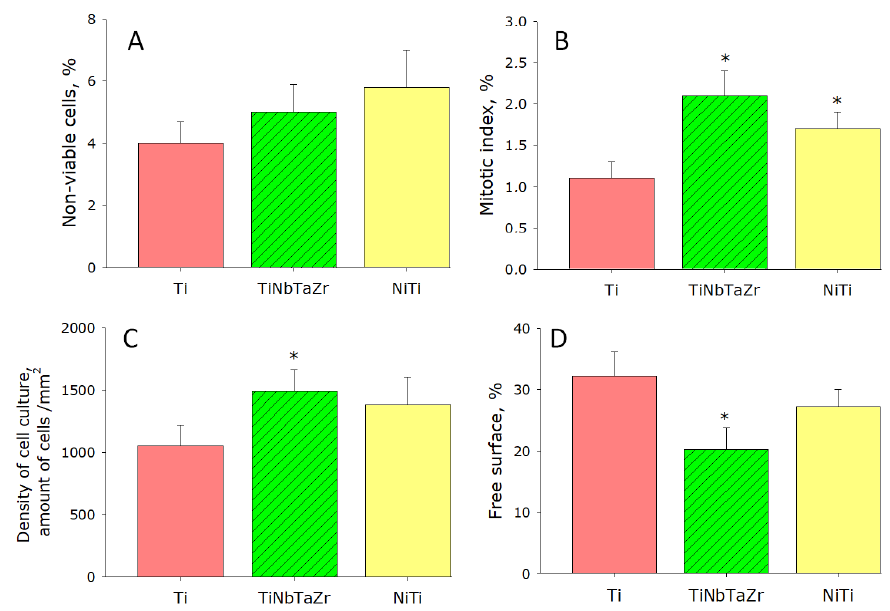
Figure 5. Effect of the Ti–25Nb–13Ta–5Zr alloy on the main characteristics of cell culture growth and